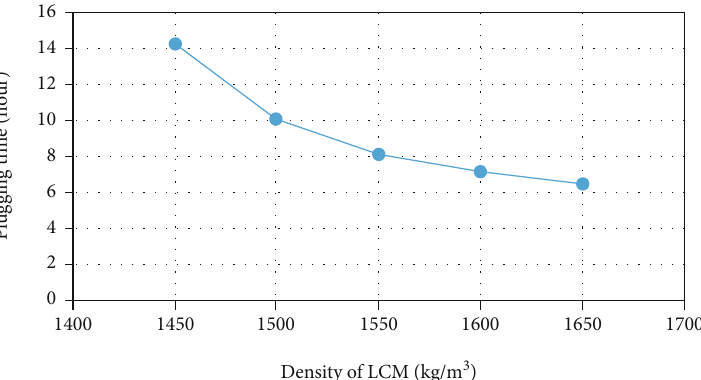
Figure 13: Plugging time versus density of LCM.